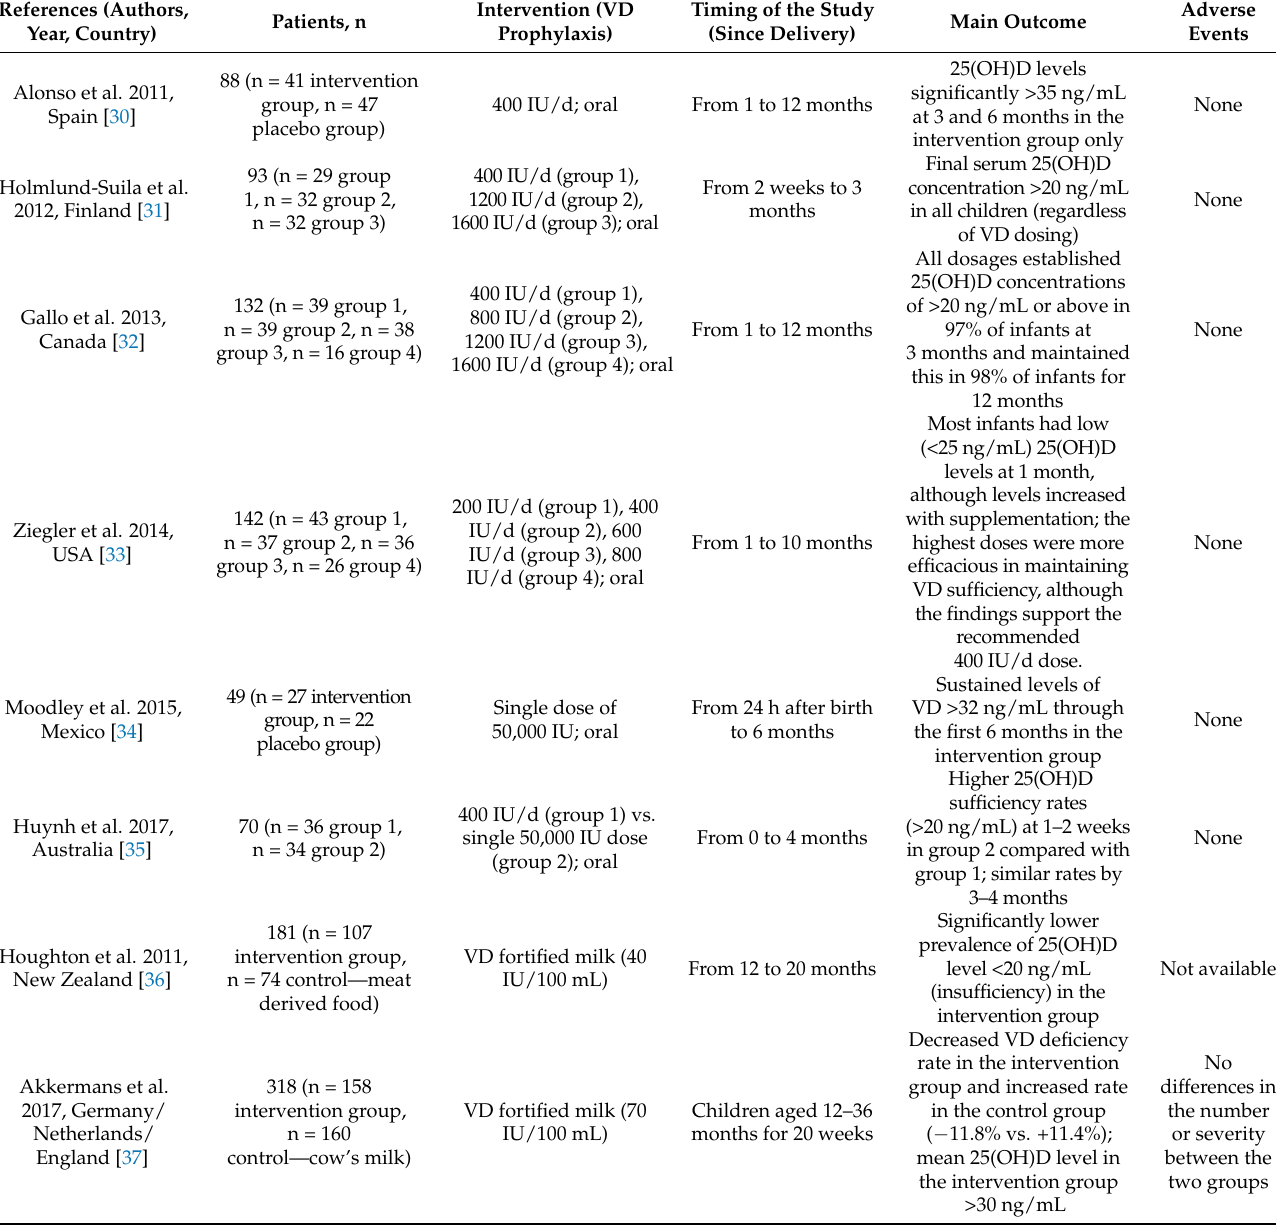
Table 1. Studies investigating Vitamin D supplementation for